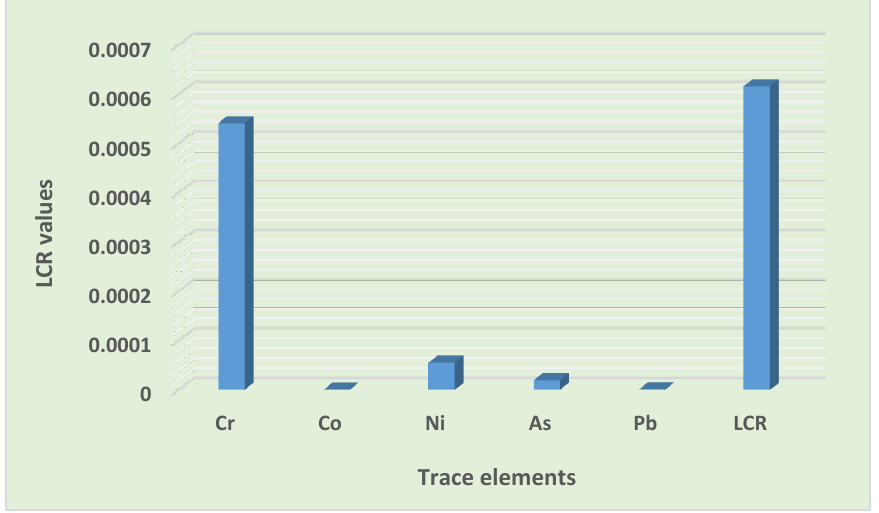
Figure 10. Contribution of trace elements to lifetime carcinogenic risks.